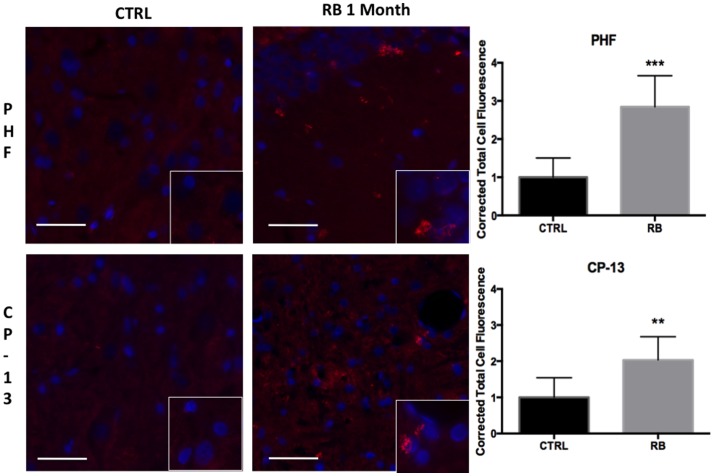
Tau conformational markers were increased throughout the contralateral superficial cortex. PHF was significantly increased at 1-month post repetitive blast (t = 6.055, p < 0.001). CP-13 staining was also significantly increased following repetitive blast (t = 3.883, p < 0.01). CP-13 was increased in a perivascular distribution. Tau conformational change is required for the formation of neurofibrillary tangles. Values were calculated using a student’s t-test comparing the mean difference between groups.